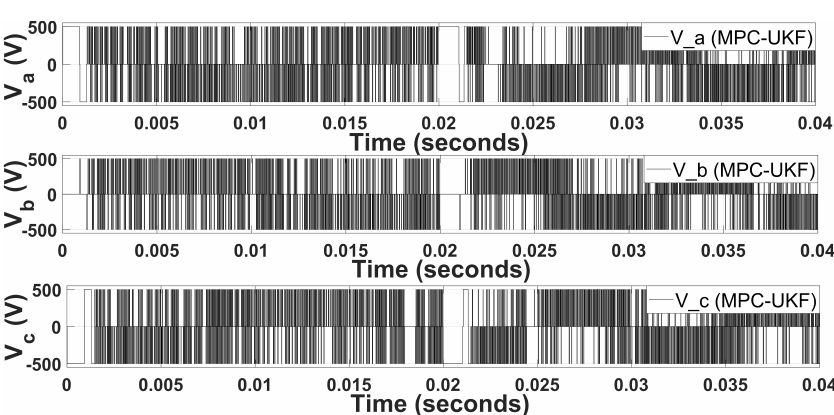
Figure 5. Three-phase stator voltages for MPC-UKF.